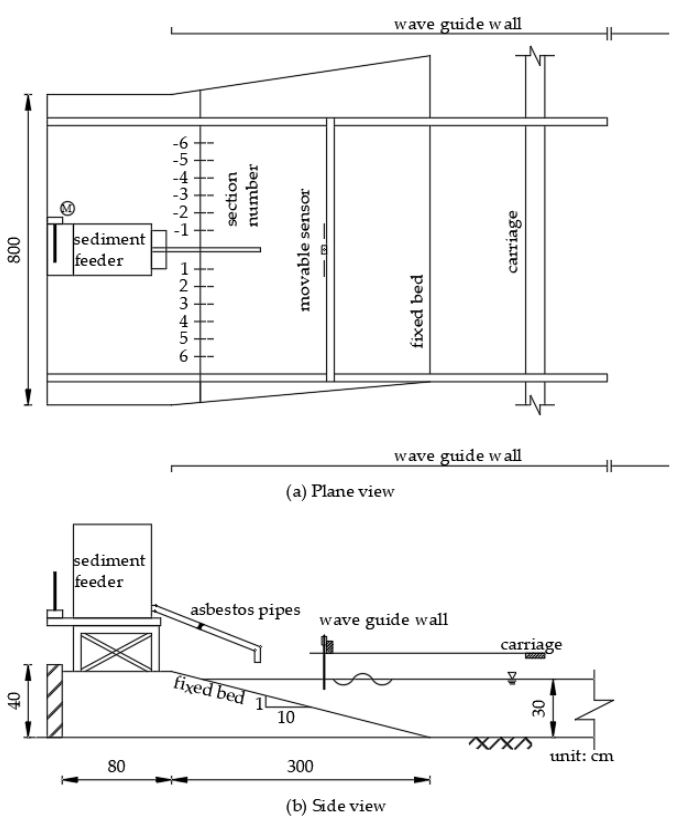
Figure 8. Schematic diagram of experiment for formation of river deltas [2]. ( a ) Plane view; ( b ) Side view.